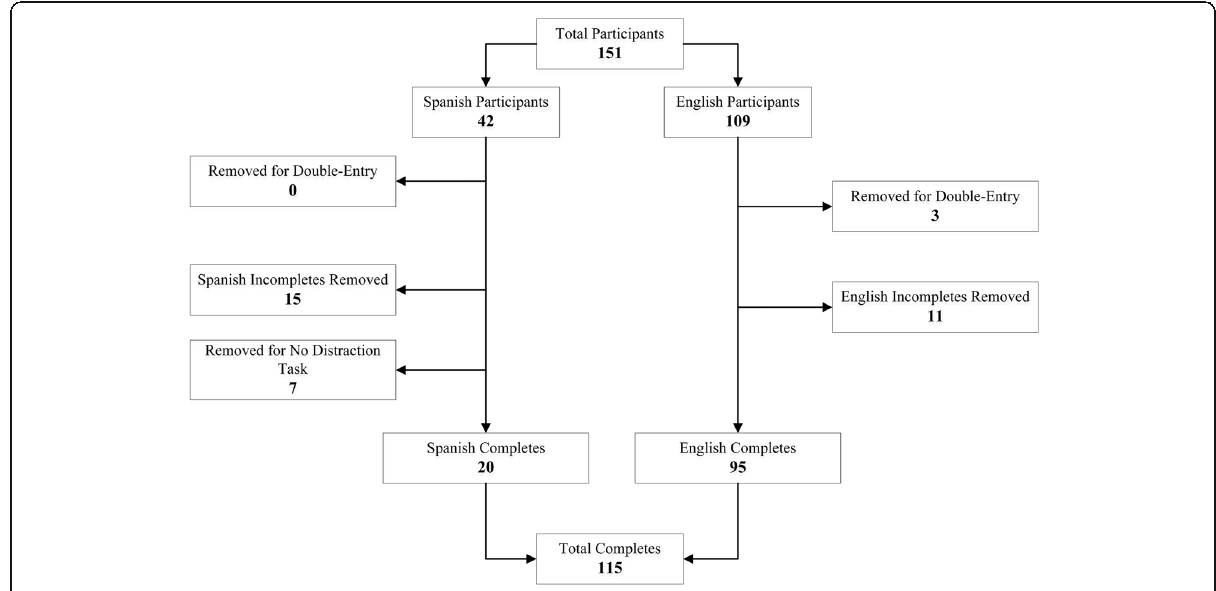
Fig. 2 The flow of data gathering